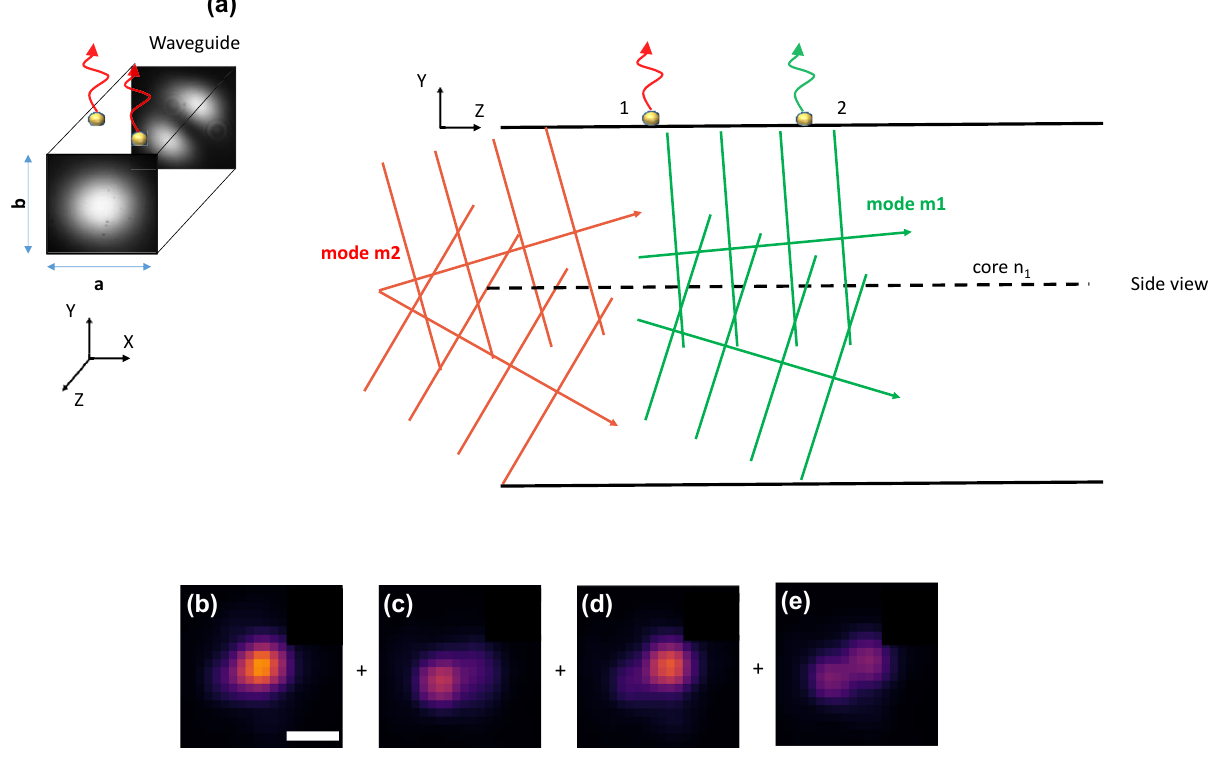
Figure 2: Theory of cELS image formation. (a) A rectangular waveguide with transverse widths ‘‘ a ’’ and ‘‘ b ’’ units guiding power via fundamental and higher-order modes is shown. The two modes m1 and m2 are shown in green and red color respectively in the side view diagram. The modes are decomposed into a pair of plane waves propagating at discrete angles with respect to the optical axis along z . The evanescent tails of these guided modes polarize particles 1 and 2 placed on the surface and scatter into the far-field. (b–e) Experimental demonstration of the theory of image formation using a multi-moded waveguide. The images are of 100 nm gold nanoparticles imaged using a 10X/0.25 NA MO. The multi moded speckle pattern causes variations in the intensity of the coherently scattered light. Scale bar 2 μ m.